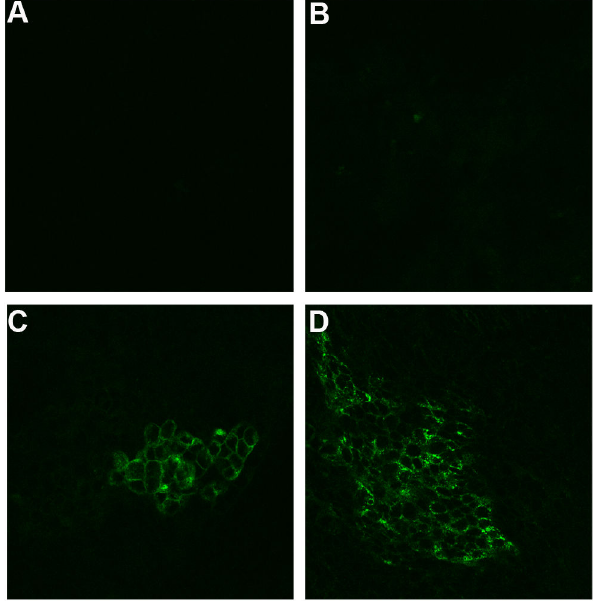
cells (absorbance is inversely proportional to cell death). Each point represents the average value from three wells, and the data shown are representative of three individual experiments.